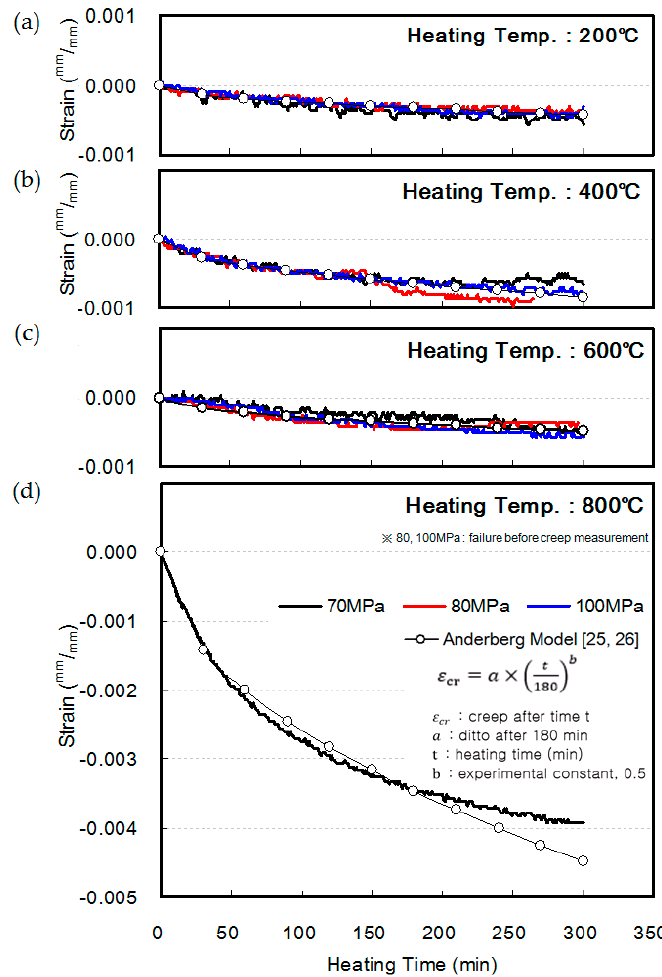
Figure 11. Creep of HSC at elevated temperature: ( a ) 200 °C; ( b ) 400 °C; ( c ) 600 °C; ( d ) 800 °C.